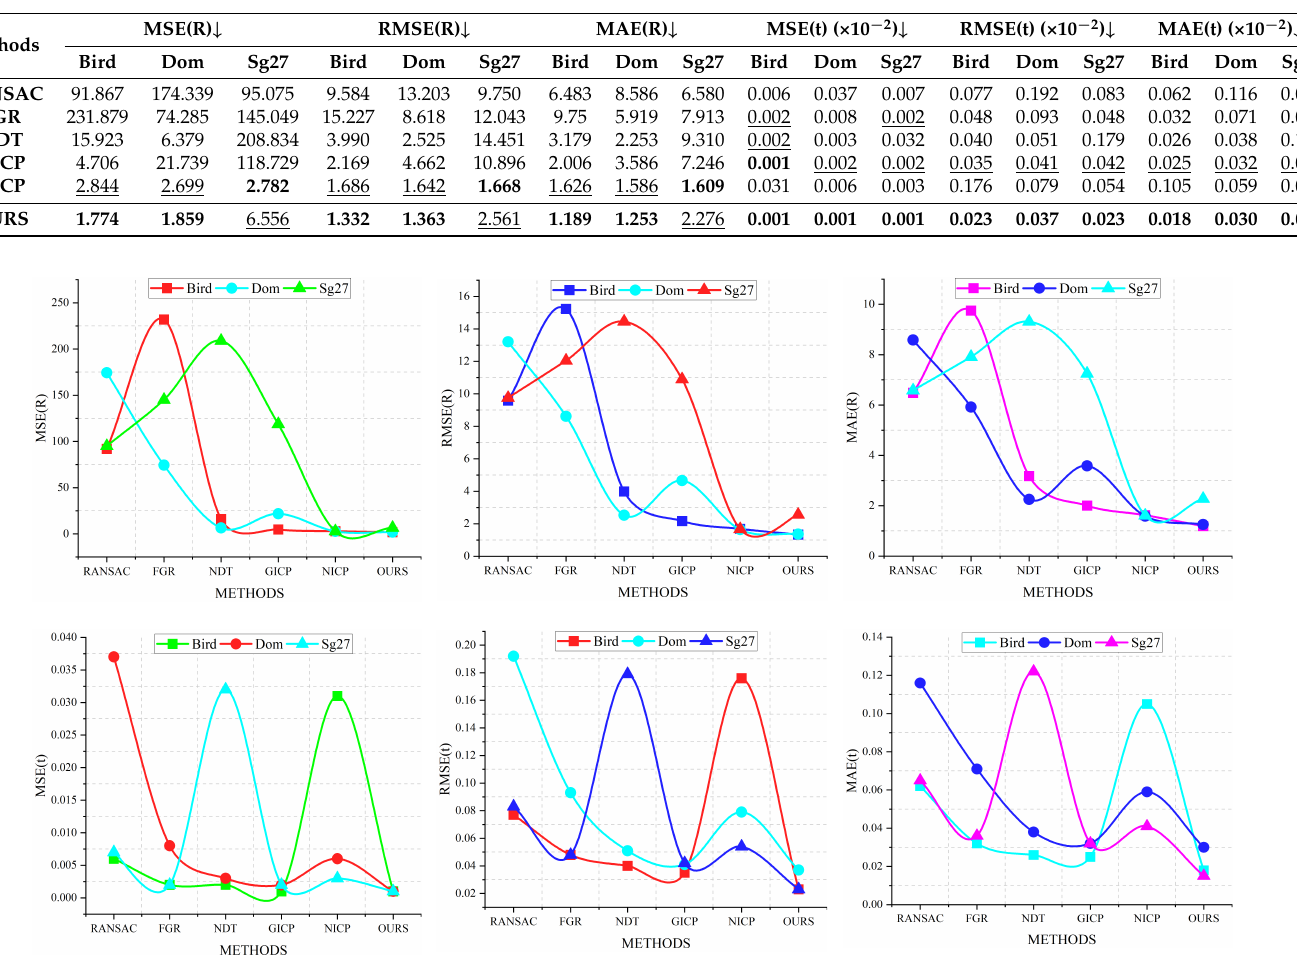
Table 3. Evaluation of results from third-party databases. Based on third-party test samples, we evaluated the performance of our method and other similar methods. (The ↓ indicates that the smaller the value, the better; bold indicates the best performance; underline indicates the second- best performance.)